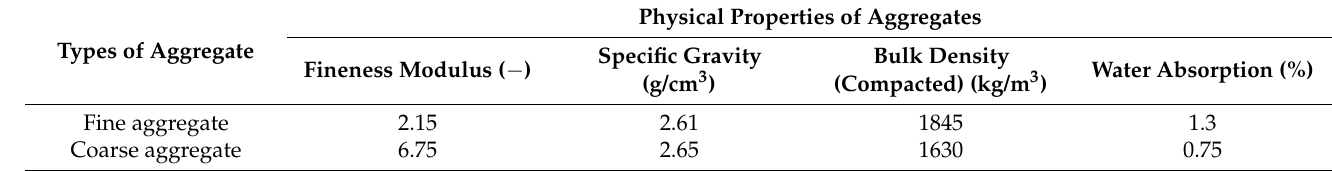
Table 2. Physical properties of aggregates.